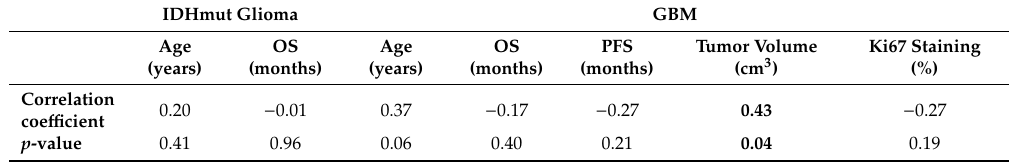
Figure 2. Association of MPS1 mRNA expression with GBM-patients’ symptoms, tumor localization, and tumor volume. ( a ) Pie charts of the reason for initial hospitalization and tumor localization of GBM patients with MPS1 mRNA expression below and above the median expression (49-fold). Shown is the percentage of patients belonging to each group. ( b ) Scatter diagram of MPS1 mRNA expression compared to the GBM tumor volume. Linear regression, p -values were calculated by ANOVA based on ∆∆ Cq-values. The global e ff ect size was determined by Cohen’s f . Table 4. Correlation of patient and tumor characteristics with MPS1 mRNA